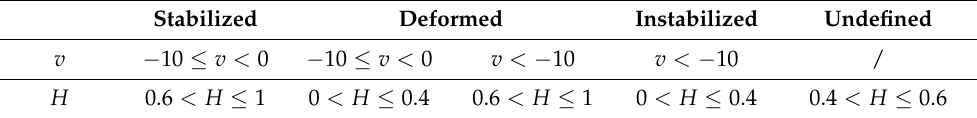
Figure 5. Spatial distribution of Time-Series InSAR measurement points (slope direction) and deformation rate ( 1 (cid:13) Laotangfang landslide; 2 (cid:13) Sharentian landslide; 3 (cid:13) Sifangbei landslide; 4 (cid:13) Xiangjiaping landslide; 5 (cid:13) Tangjiao landslide; 6 (cid:13) Rangduchangbei landslide; 7 (cid:13) Datangbang landslide; 8 (cid:13) Jinjinzi landslide; 9 (cid:13) Wuchiba landslide; and 10 (cid:13) Zhangjiacitang landslide). Table 2. Deformation trend prediction based on deformation rate (mm/yr) and Hurst